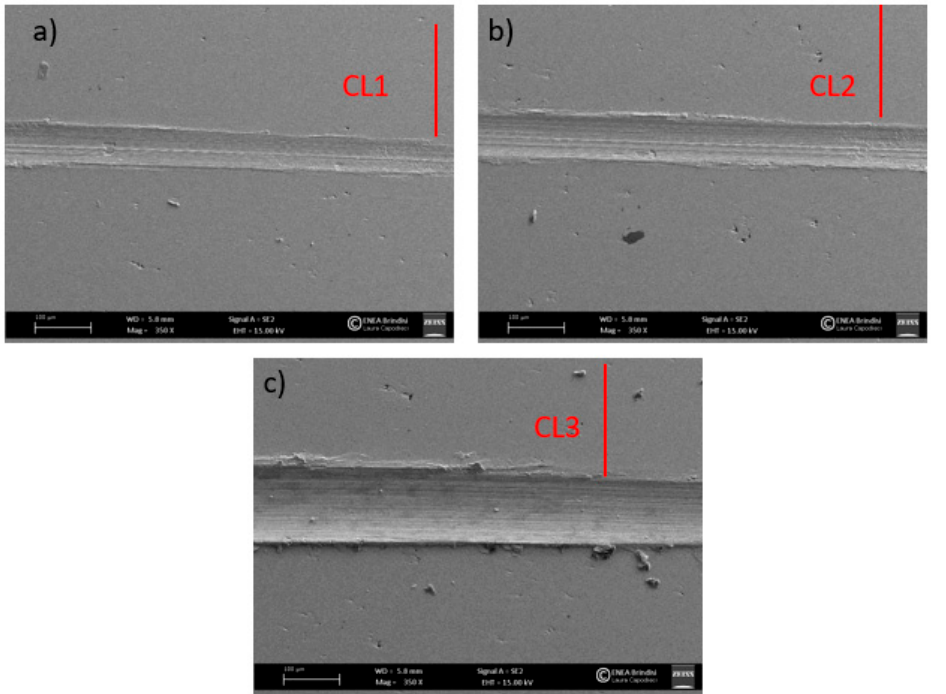
Figure 6. Individuation of critical loads from the scratch tracks in the locations corresponding to the critical load 1 ( a ), load 2 ( b ) and load 3 ( c